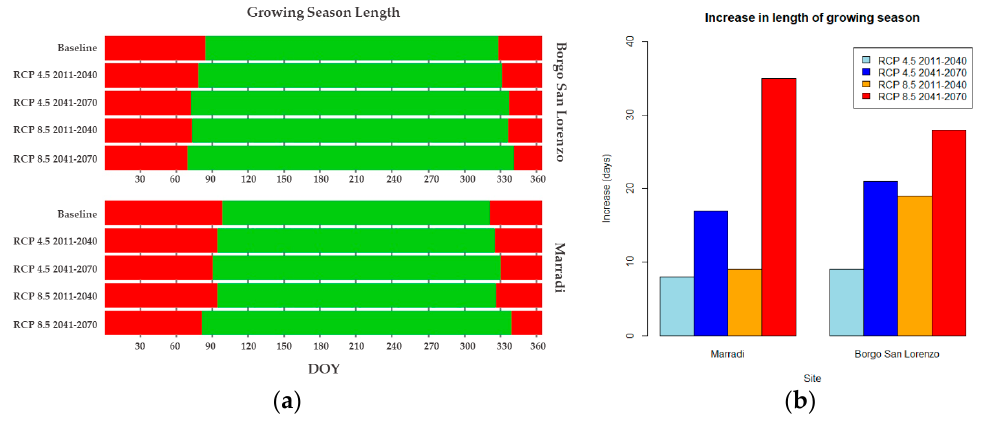
Figure 5. Estimated durations (30-year mean values) of vegetation growing seasons (green bars) for baseline and climate change scenarios under business-as-usual management at both study sites ( a ). On the right, increases of growing season length compared with the baseline ( b ).